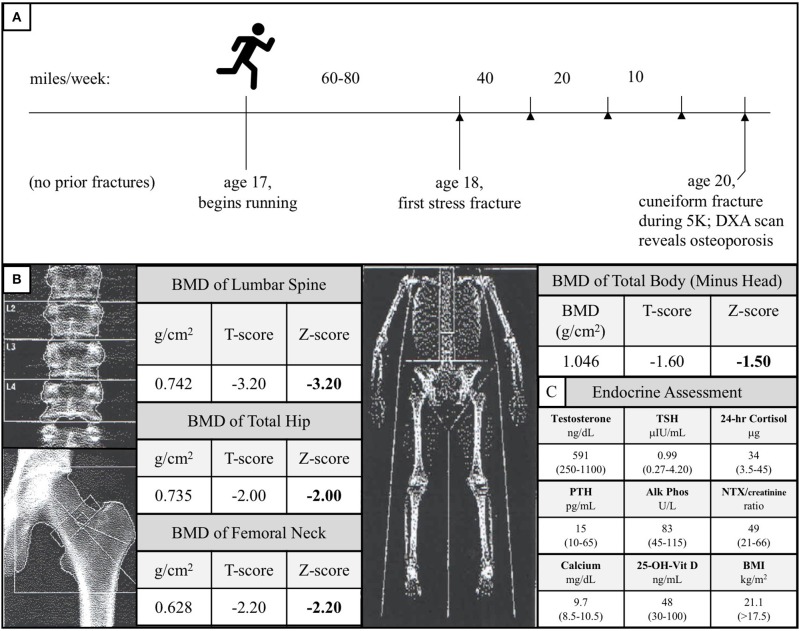
(A) Diagram of the subject's running and stress fracture history. The subject had no history of fractures during his childhood and began distance running at age 17. He successfully ran 60–80 miles per week for over 1 year before experiencing his first fracture in his right lateral tibial plateau. Over the subsequent years, as he continued to run, his mileage threshold to fracture decreased precipitously (stress fractures are represented by arrowheads). At age 20, he fractured his right cuneiform during a 5-kilometer road race. A follow-up of the unusual foot fracture revealed osteoporosis. (B) DXA scan of the subject's lumbar spine, total hip, femoral neck, and total body (minus head) at time of diagnosis. These data are consistent with the notion that the subject's load-bearing bones failed to adapt to the mechanical stress of running. (C) Endocrine assessment at time of diagnosis. Reference ranges are given in parentheses and BMI >17.5 kg/m2 is used because this threshold is a surrogate marker for Relative Energy Deficiency in Sport (RED-S) in men (33, 34).